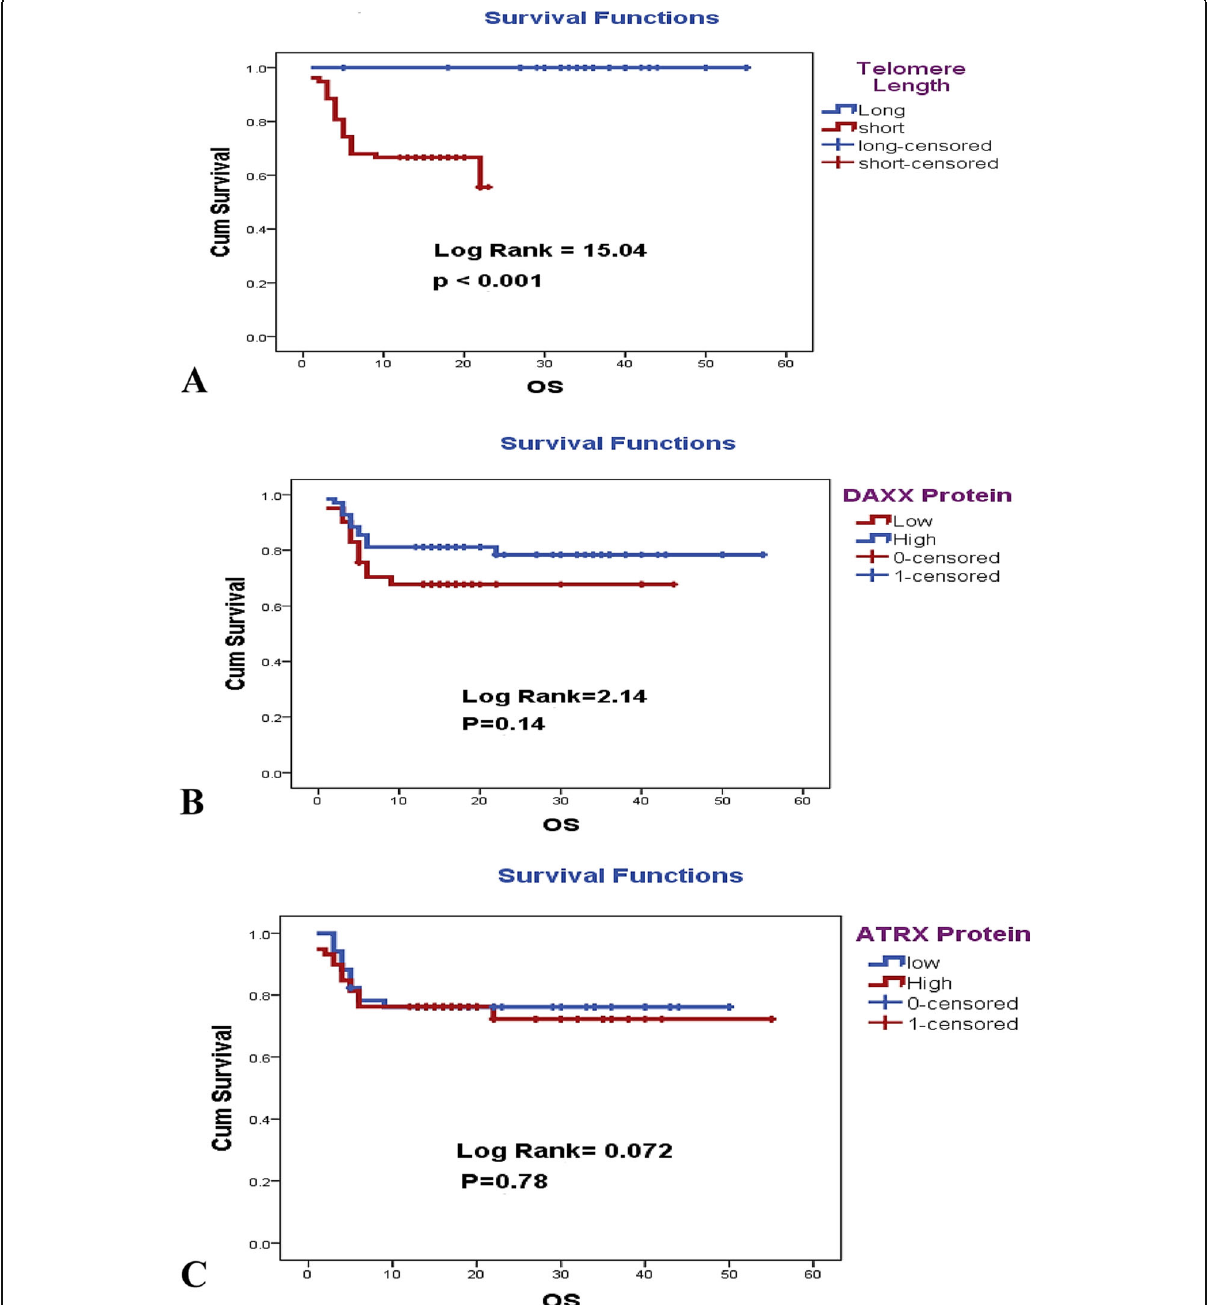
Fig. 4 OS for telomere length, DAXX, and ATRX expression. a Telomere shortening is associated with poor OS. b ATRX and c DAXX low expression did not show bad impact on